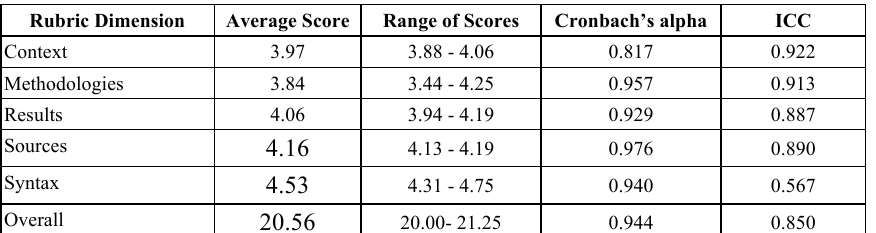
Fig. 1. Total Scores using the Technical Writing rubric for the capstone research and design projects under assessment. Table 1. Technical Writing Rubric Mean Scores, Cronbach alpha and Inter-rater Reliability